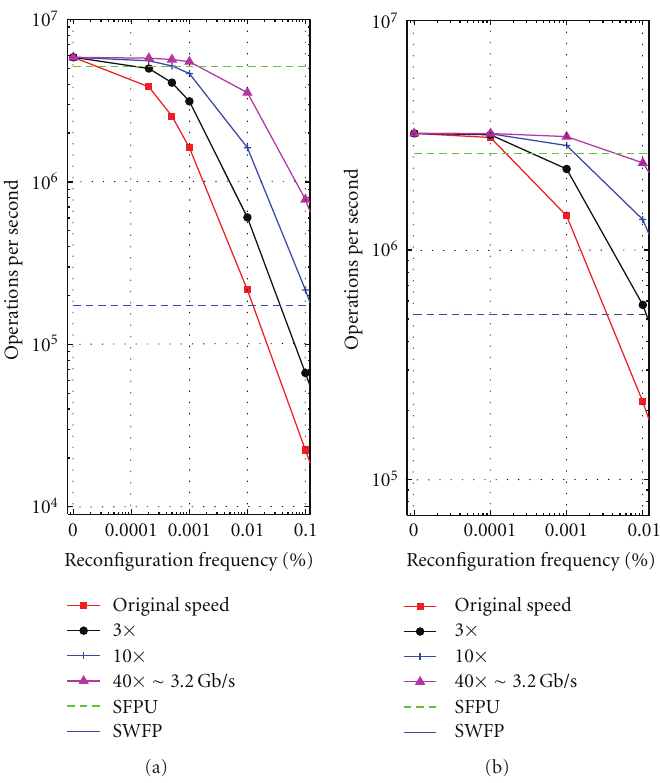
Figure 11: Performance bound curves at the theoretically maximum possible reconfiguration data rate speeds for Virtex II Pro MicroBlaze (a) and Virtex 4 PowerPC405 (b). Here, 0% cannot be represented in our logarithmic scale, thus it was included as the leftmost point in the graph. The original speed measurement (square red) was taken using running hardware systems described in Section 5. The round (black), plus (blue), and triangle (pink) curves were estimated scaling the results from the original speed